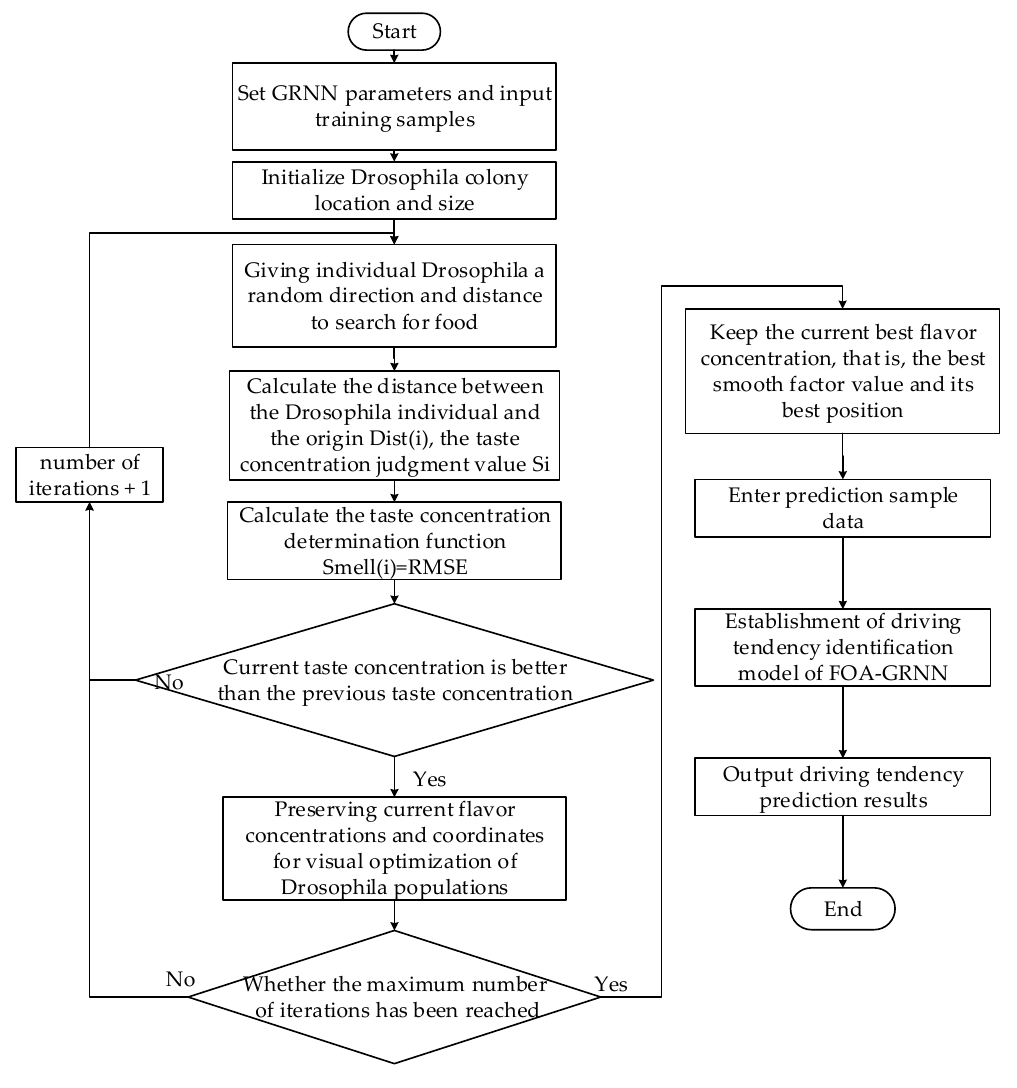
Figure 9. Flow chart of the FOA optimization GRNN